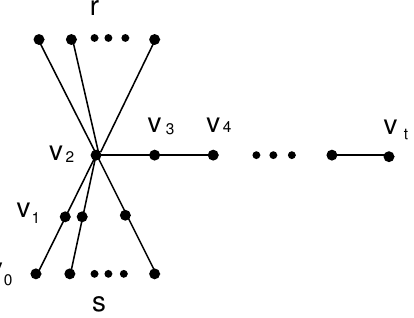
Figure 1. The local structure of T